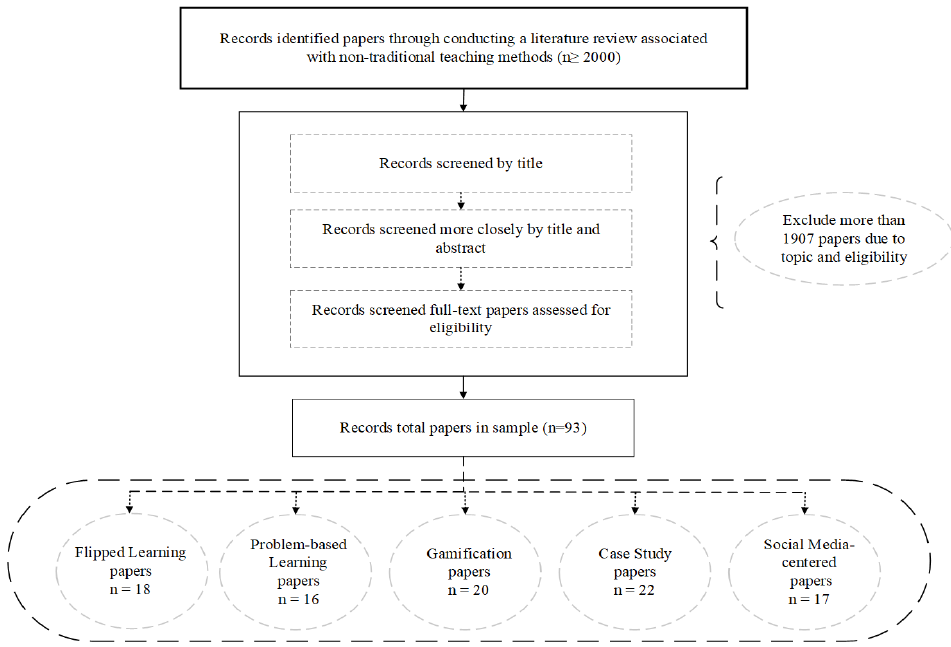
Figure 2. Process of paper search and selection.